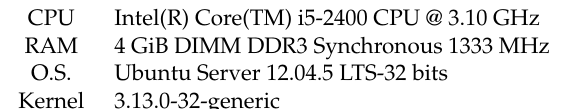
Table 3. Cooja test-bed specifications.